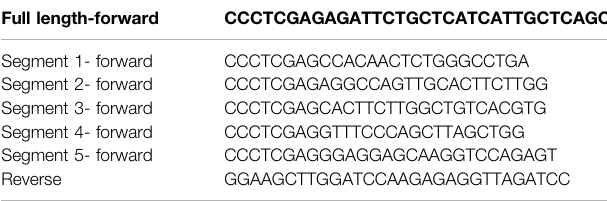
TABLE 1 | Primers used in C4 promoter luciferase assay (5 ’— 3 ’